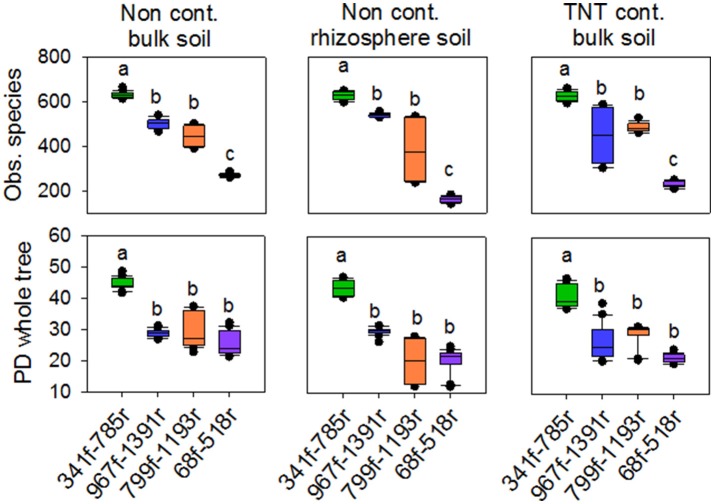
Box plots of observed species and phylogenetic diversity for the four primer pairs used in this study, 68f/518r, 341f/785r, 799f/1193r, 967f/1391r. Average number of observed species was based on 97% sequence similarity cut-off value. Averages were calculated based on a rarefied depth of 1,000 sequences per sample, across the replicates for each primer pair. Different letters denote significant differences (Kruskal Wallis, p < 0.05).